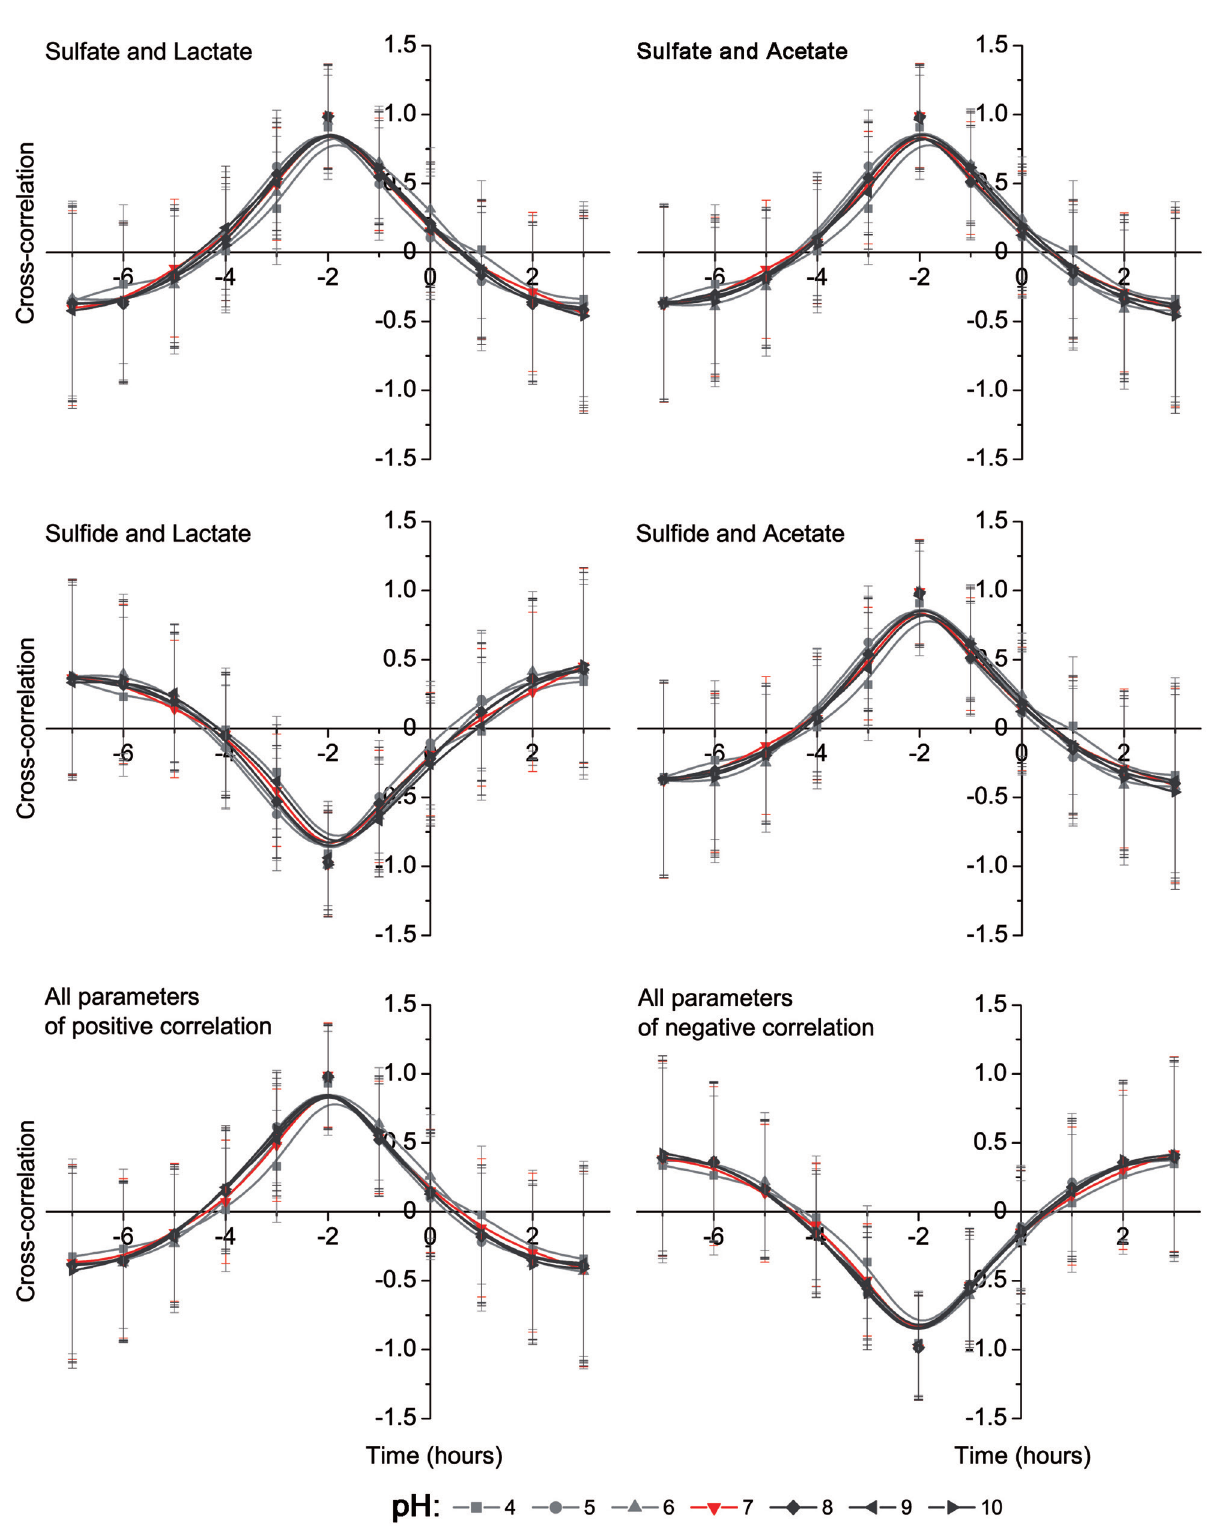
Figure 4: Cross-correlation analysis between sulfate consumption and lactate oxidation, acetate production as well as sulfide and lactate, same as between sulfide and